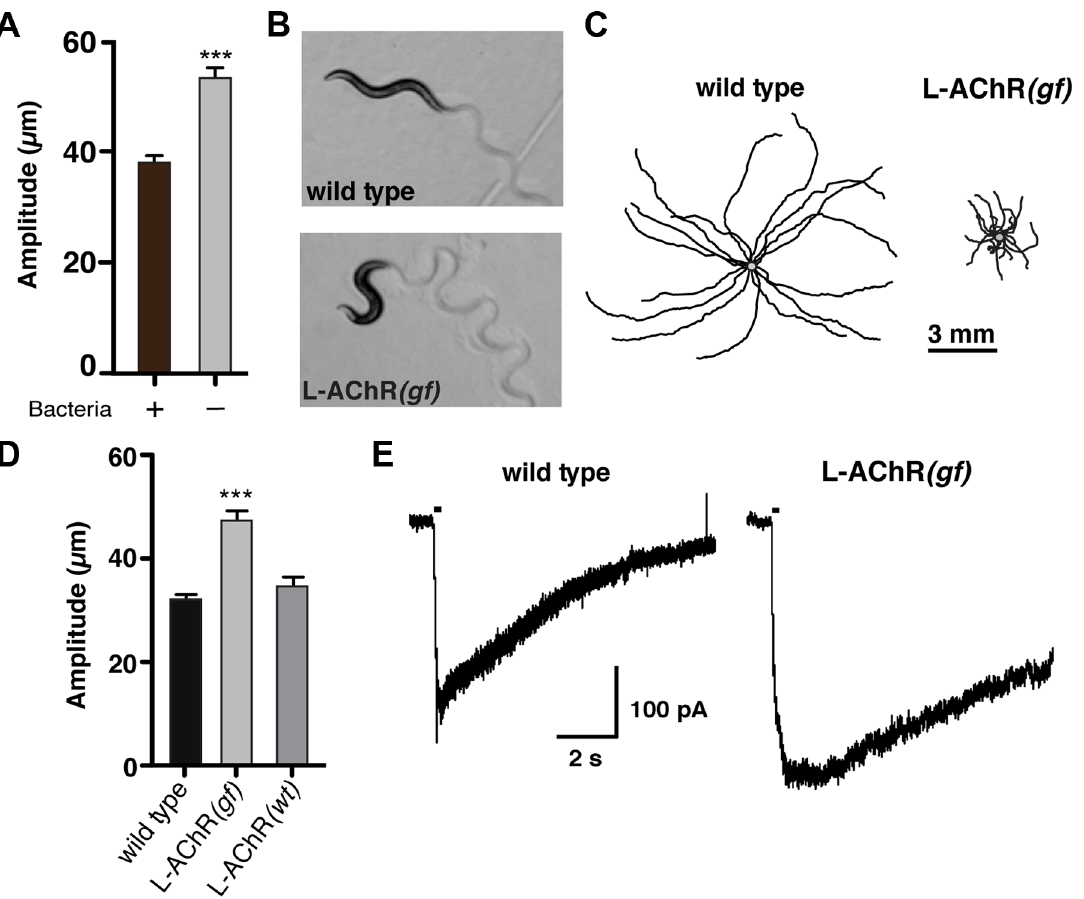
Figure 1. Enhanced L-AChR function increases neuromuscular signaling and alters the C.elegans locomotory pattern. ( A ) Average body bend amplitude of wild type worms in presence ( + ) or absence ( 2 ) of bacterial food. Well-fed animals were transferred to assay plates with or without food and videotaped for 45 s following a recovery period of one minute. Bars represent the mean ( 6 SEM) of values calculated from 15 animals. ***, p , 0.0001 student’s t-test. ( B ) Representative images of wild type and L-AChR (gf) animals. Note the exaggerated track amplitudes and the hypercontracted body posture of L-AChR (gf) animals. ( C ) Movement trajectories of wild type and L-AChR (gf) animals. Each black line shows the trajectory of one animal monitored for 45 s on food. In this and subsequent figures, tracks are aligned to a common center point (gray) for clarity. ( D ) Average body bend amplitude for wild type, L-AChR (gf) and L-AChR (wt) animals as indicated. Values for body bend amplitude were calculated from recordings of the tracks shown in C. Bars represent the mean ( 6 SEM) of values calculated from at least 15 animals. ***, p , 0.0001 by ANOVA and Sidak’s post-hoc test. ( E ) Current responses to pressure application of levamisole (100 m M) recorded from body wall muscles of wild type and L- AChR (gf) animals. Holding potential was 2 60 mV. Black bars indicate the duration of levamisole application (200 ms). See Figure 6 for additional electrophysiological characterization of the L-AChR (gf) strain.